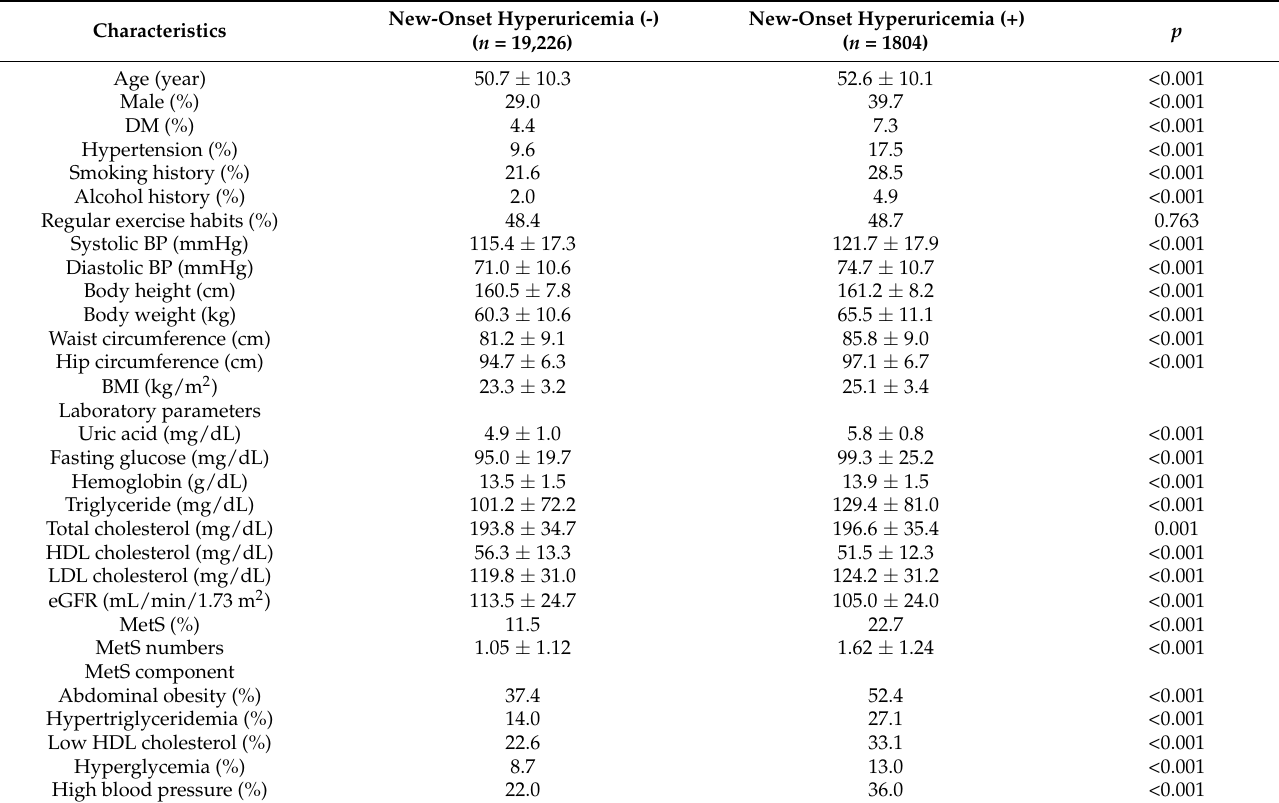
Table 1. Comparison of clinical characteristics among participants according to new-onset hyper- uricemia in study participants.